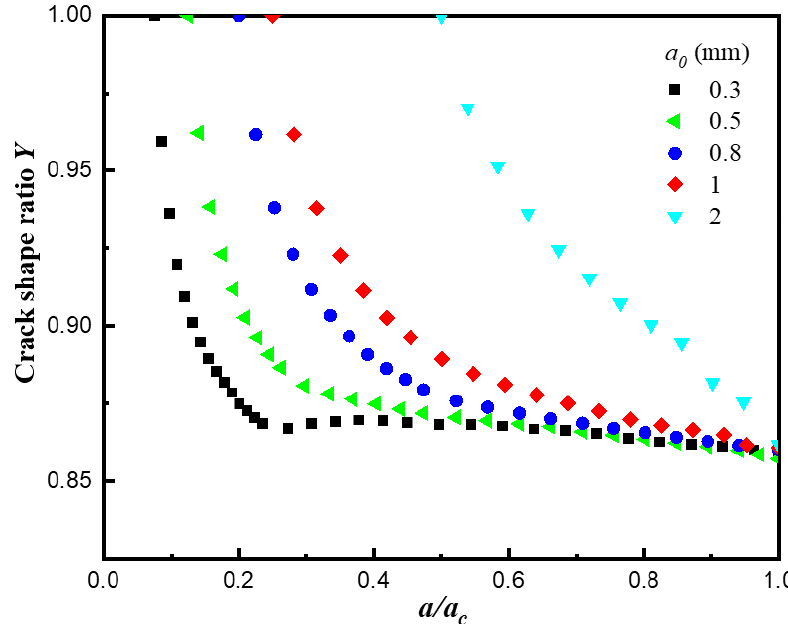
Figure 11. Variation of shape ratio during crack propagation.